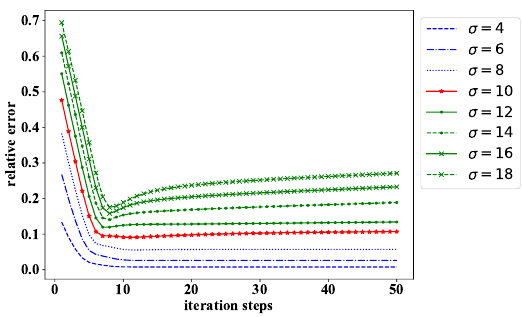
Figure 4. The relative error of each conductivity when SNR = ∞ .